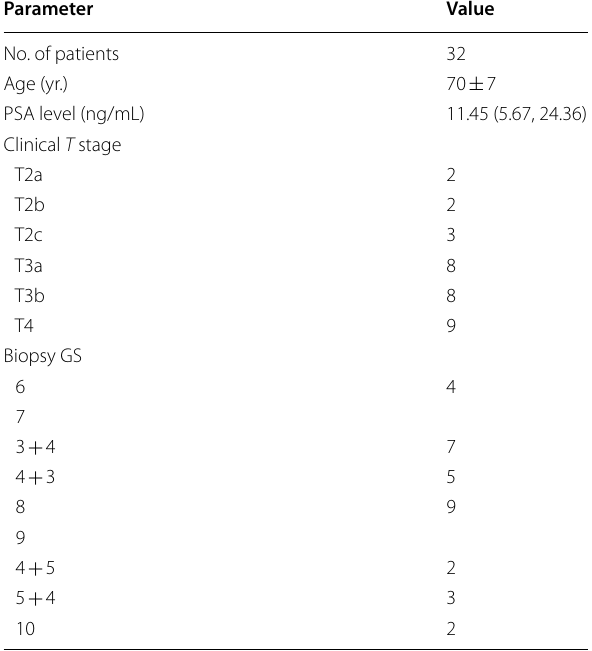
Table 2 Summary of patient characteristics Parameter Value